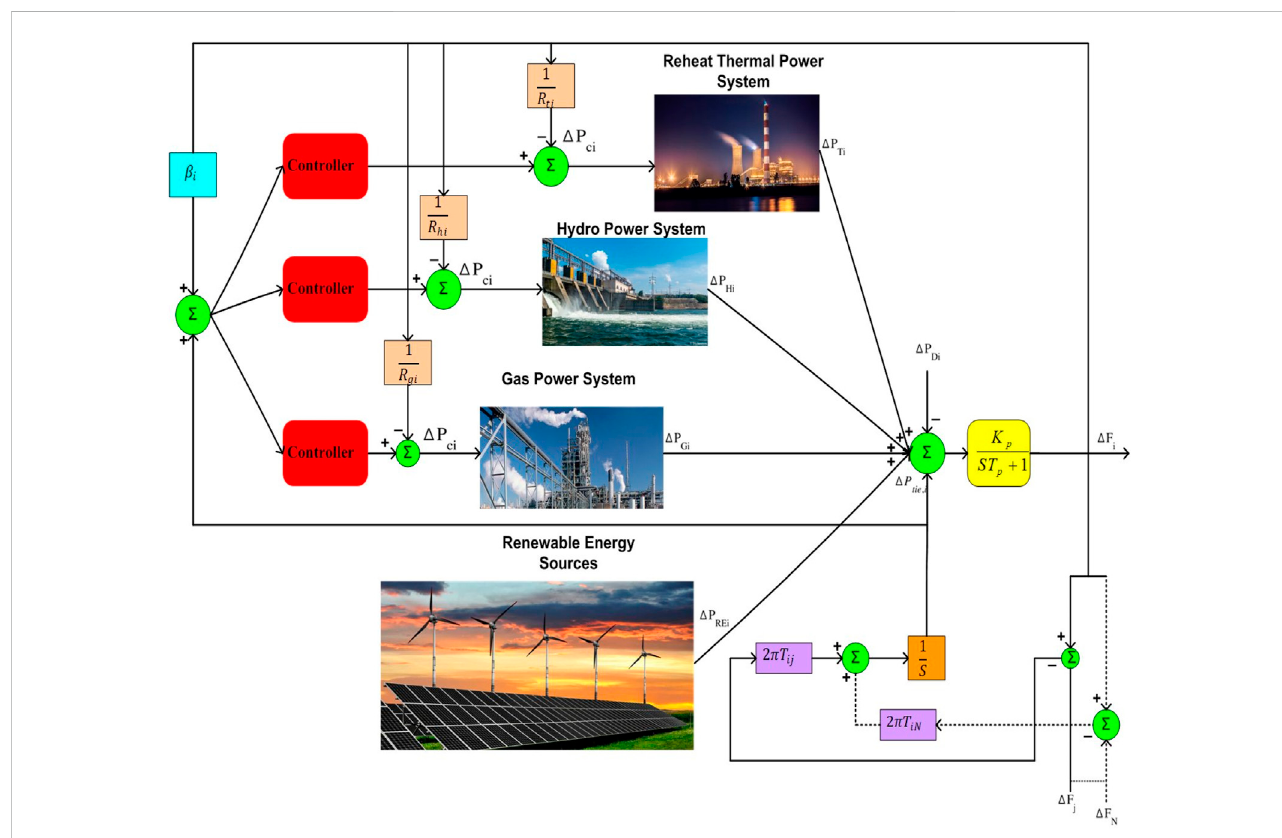
FIGURE 1 Schematic overview of multi area interconnected hybrid diverse power